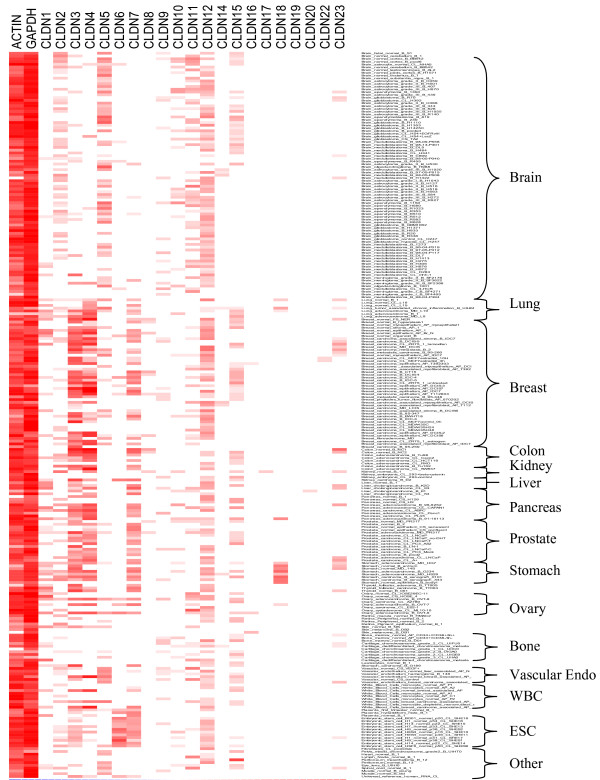
In silico analysis of claudin gene expression in various normal and neoplastic tissues. 266 SAGE libraries were examined for the expression of all 21 CLDN genes using SAGE Genie [23]. SAGE data was compiled from both normal and cancerous tissue, and analyzed using dChip software  program, which assigned darker shades of red to higher number of tags. GAPDH and ACTN levels were also analyzed as controls. While some CLDN genes are ubiquitously expressed, others exhibit highly tissue specific patterns. A detailed spreadsheet of the data is available as supplementary information.